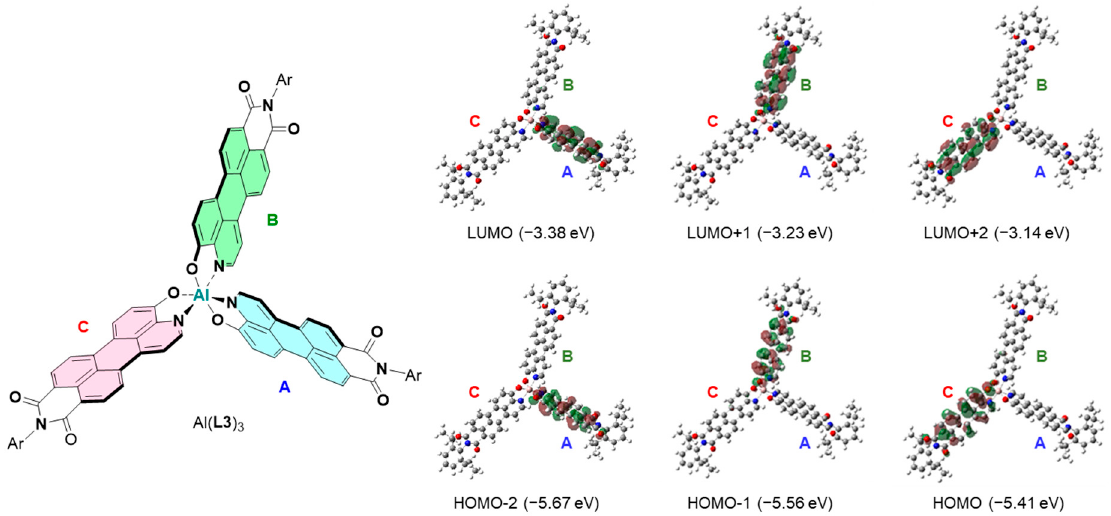
Figure 5. Selected frontier orbitals of the meridional isomer of Al( L3 ) 3 for the optimized ground-state structure calculated at the B3LYP/6-31G* level of theory. Table 2. Main electronic transitions for mer -Al( L3 ) 3 , calculated at the TD-CAM-B3LYP/6- 31G*//B3LYP/6-31G* level of theory.